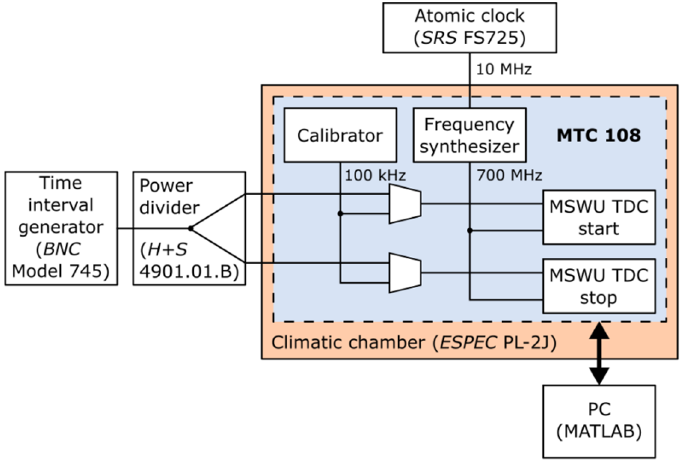
Figure 2. Test setup.